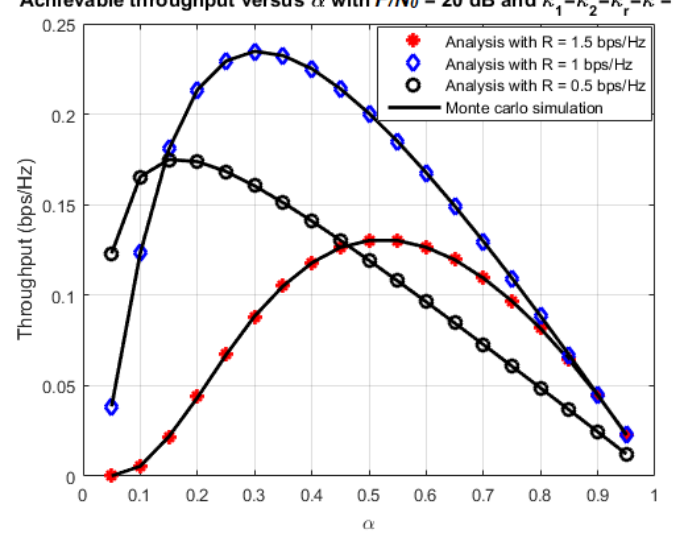
Figure 8. Achievable throughput versus α